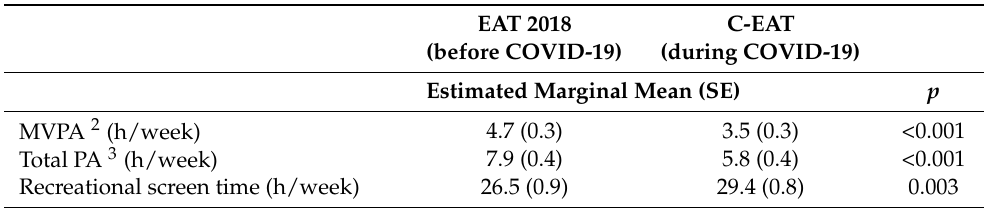
Table 2. Changes in Physical Activity and Recreational Screen Time Adjusted for Pre-Pandemic Seasonal Effects 1 .